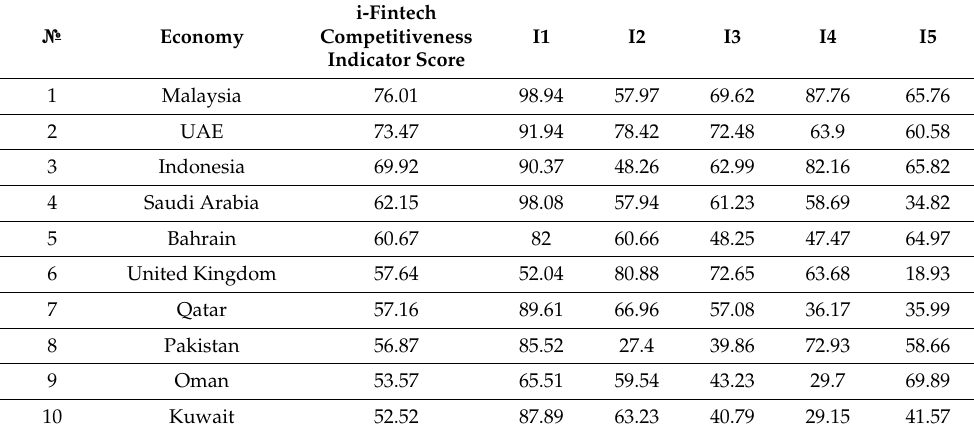
Table 2. Countries by IIFTC score and scores of